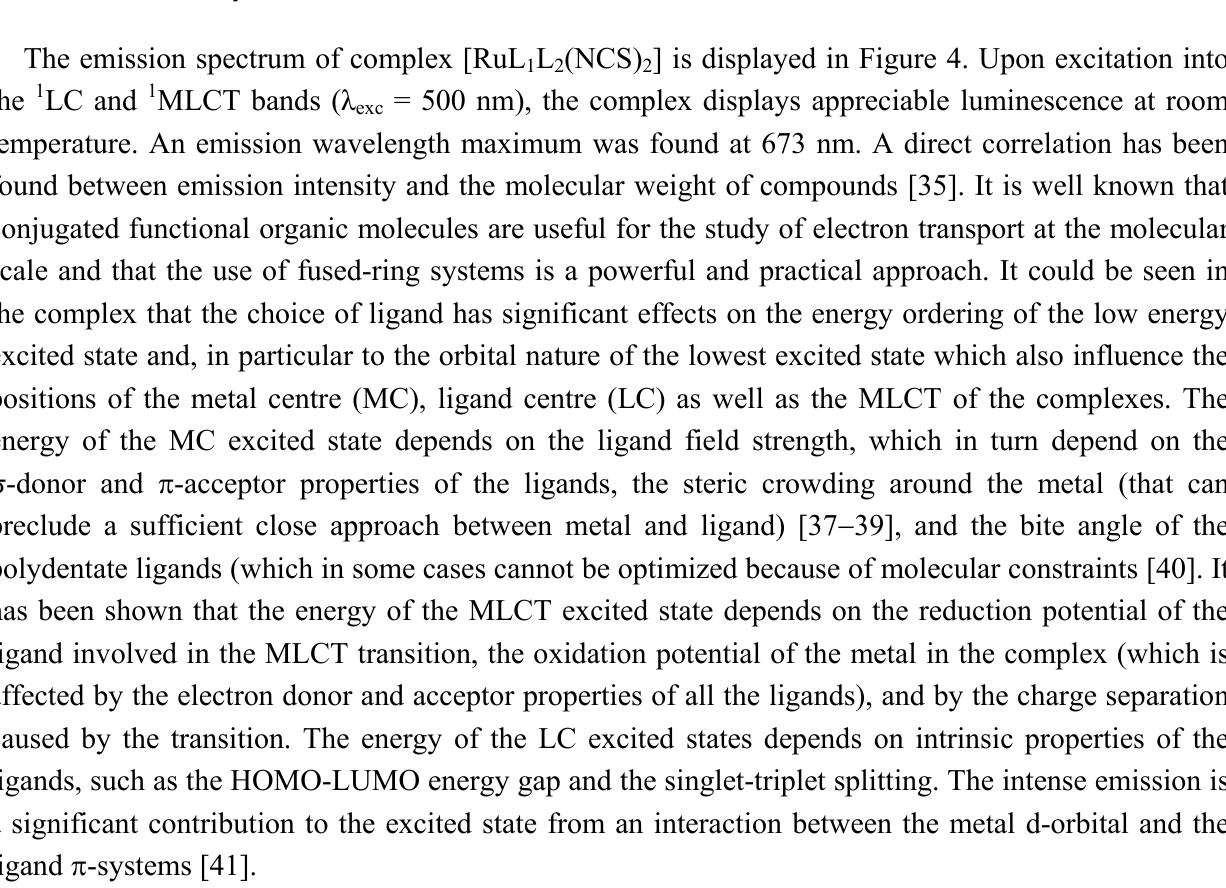
Figure 4. Emission spectrum of [RuL